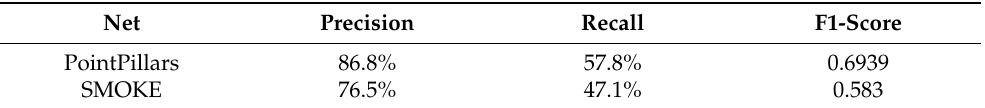
Table 1. Statistical mean index after matching the ground truth and perception results of PointPillars and SMOKE after DE (3769 frames).